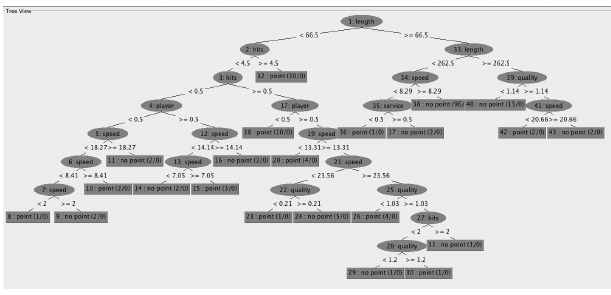
Figure 11. Decision tree (RandomTree): 57 strokes. Size of the tree: 43